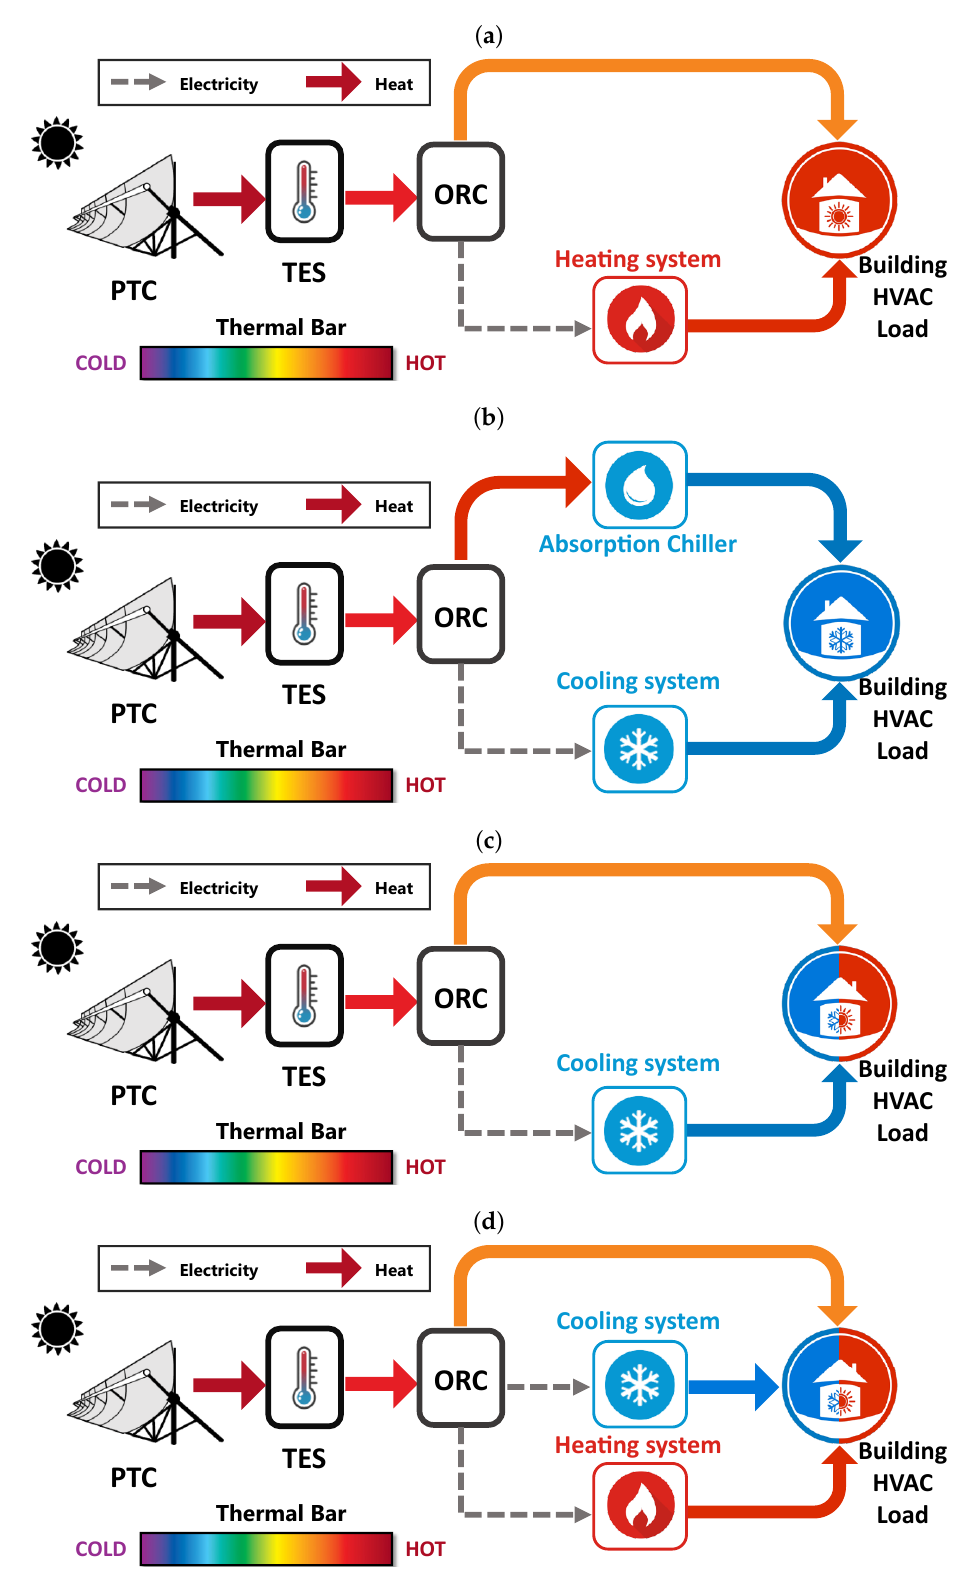
Figure 6. Architectures for MicroCSP system integration into building HVAC systems: ( a ) heating cogeneration architecture, ( b ) cooling cogeneration architecture, ( c ) combined heat and cooling cogeneration architecture, and ( d ) trigeneration